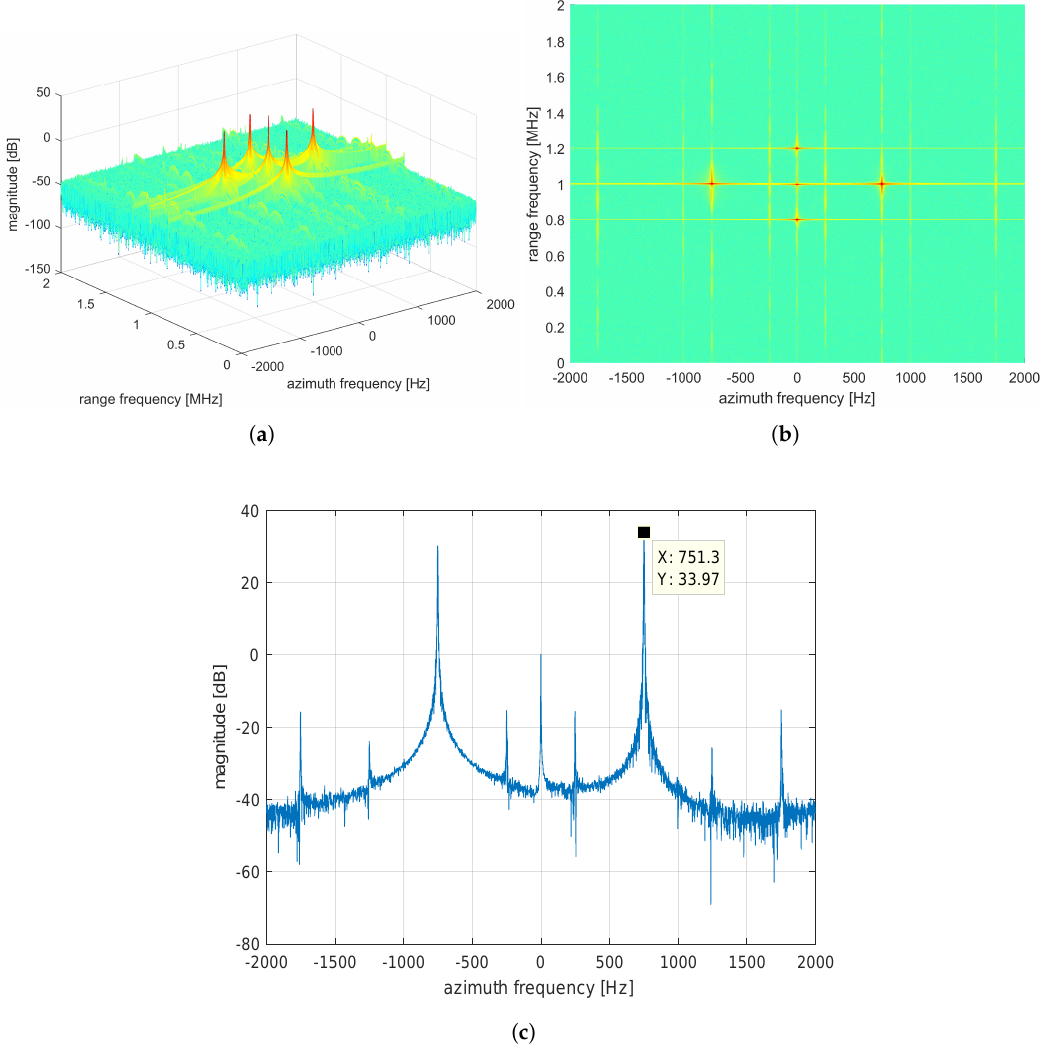
Figure 19. Simulation results after MCRA: ( a ) three-dimensional plot; ( b ) two-dimensional plot; ( c ) azimuth frequency cut at Scatterer